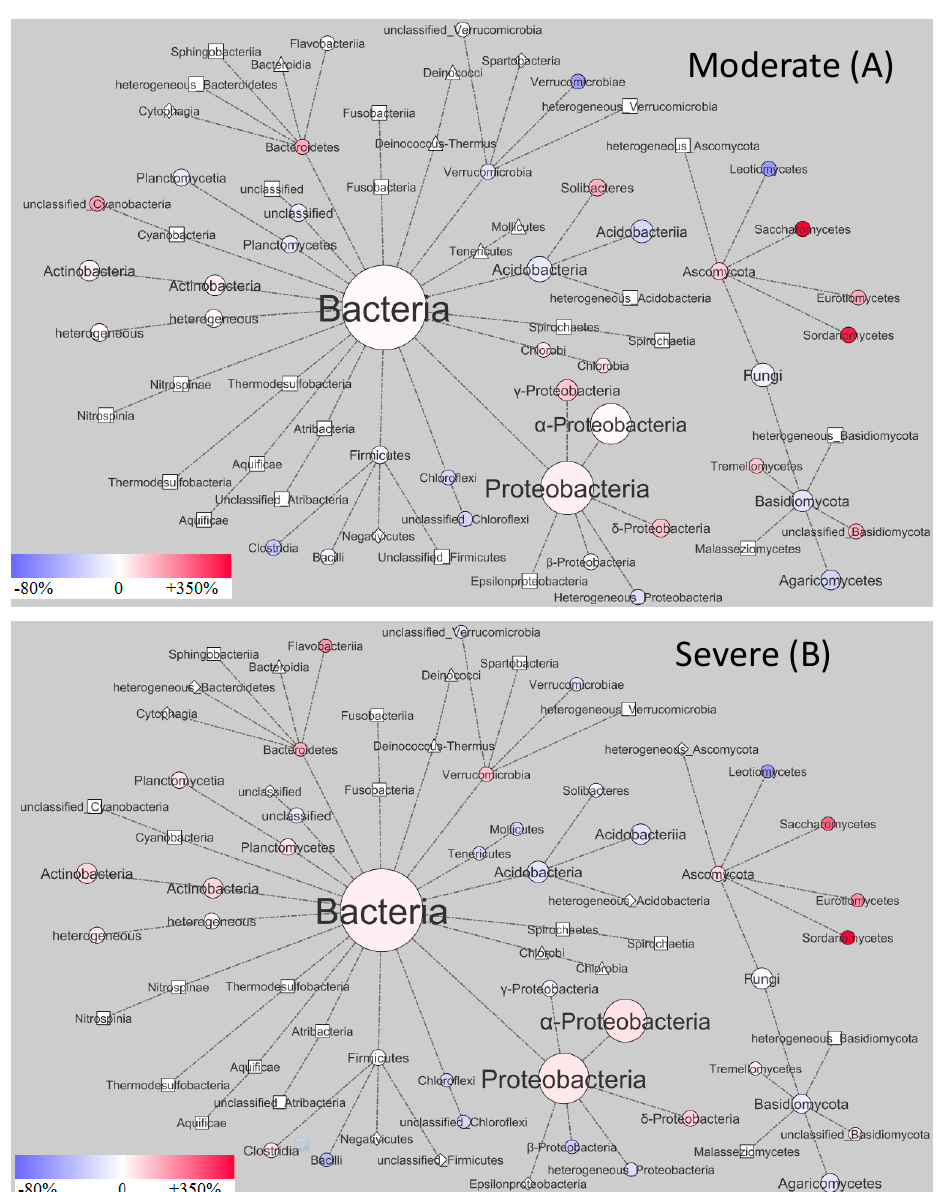
Figure 1. Phylogenetic network of proteins. Relative abundances calculated from the sum of the normalized spectral abundance factor (NSAFs) found for the control and drying and rewetting (DRW) plots: (A), moderate DRW—two consecutive cycles of four weeks of drought, then 75 mm irrigation (1 mm of precipitation refers to 1 L water m -2 ); (B), severe DRW—one cycle of eight weeks of drought, then 150 mm irrigation. The size of the nodes and labels represent the abundance of the corresponding taxonomic group. Labels are class-level assignments and shape-indicators are: Diamond , not present in control and treatments; Triangle , present in control but not in treatment; Rectangle , not present in control but in treatment; and Circle , present in both control and treatments. For the proteins that were present in both treatments (shown in circles) the gradient of color represents the increase (red) or decrease (blue) of the % change in the relative abundance of the treatment plots compared with control. ‘Heterogeneous’ means different microbial taxa that belong to more than one phylum/class/order. Values are means of two analytical replicates of four pooled biological replicates. Detailed changes of the percentage values in DRW treatments (as compared to controls) can be found in Supplementary Table 1.